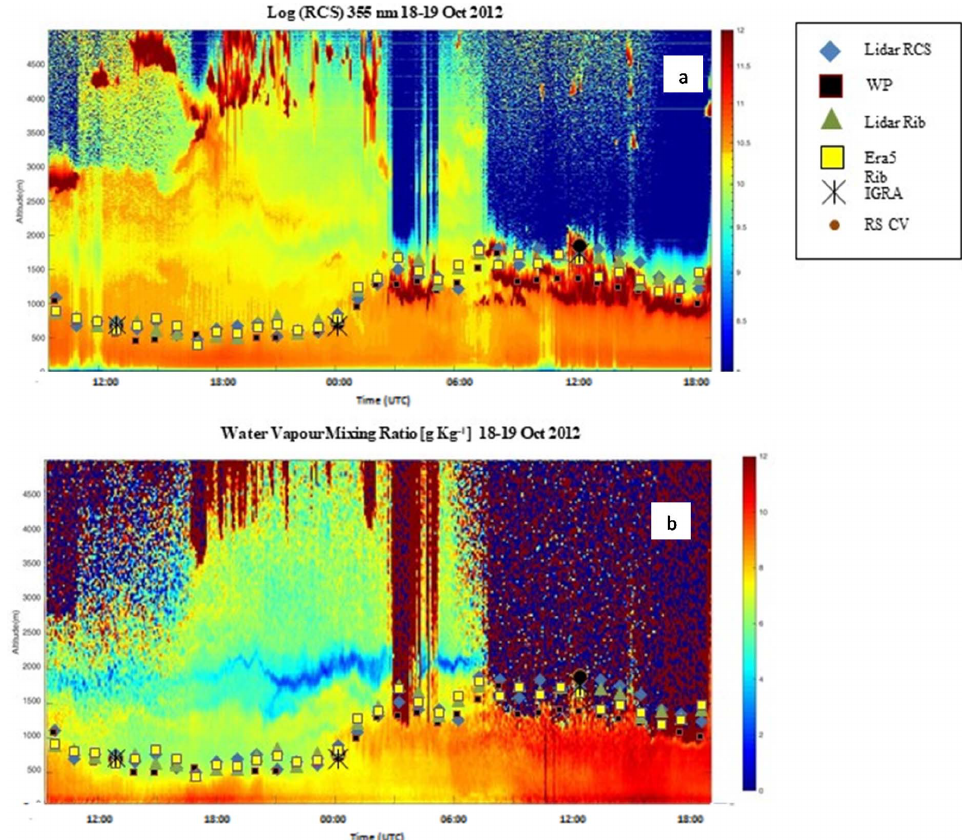
Figure 7. (a) Time–height cross section of the range-corrected signals (RCSs) at 355nm and (b) water vapour mixing ratio as measured by BASIL over the time interval from 23:00UTC on 18 October 2012 to 19:00UTC on 19 October 2012. The figure also includes the different ABL